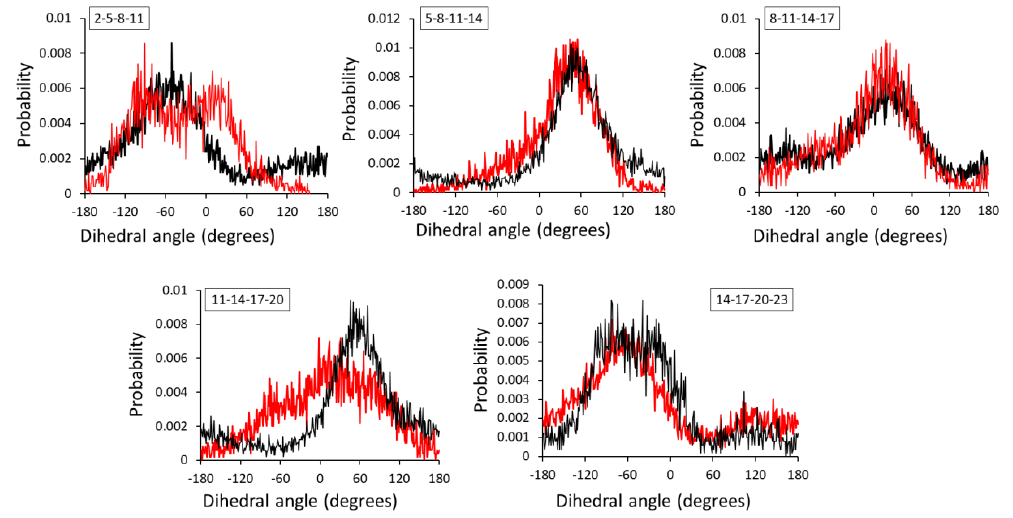
Figure 7. Main chain dihedral angle distributions of AA and CG representations for an HA octasaccharide molecule. Black and red lines indicate AA and CG representations,